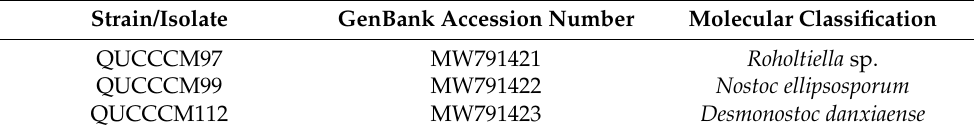
Table 1. GenBank accession numbers and molecular classification of the